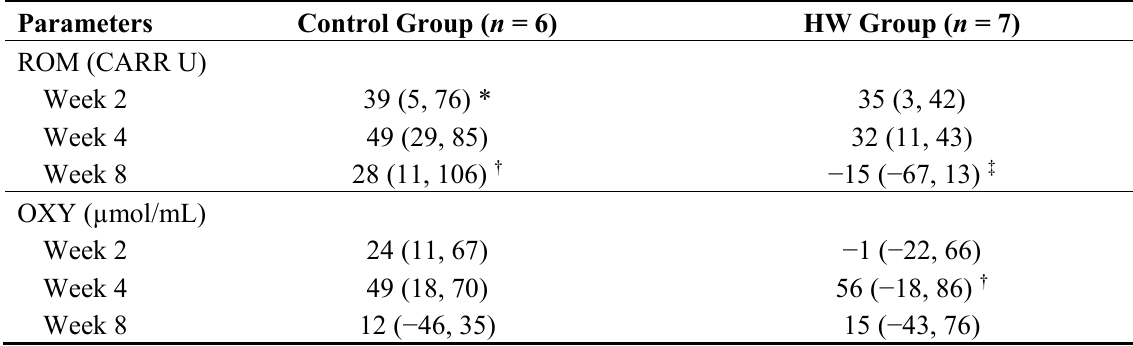
Table 4. Changes in biochemical parameters at week 2, 4 and 8 (median (25%, 75%)).